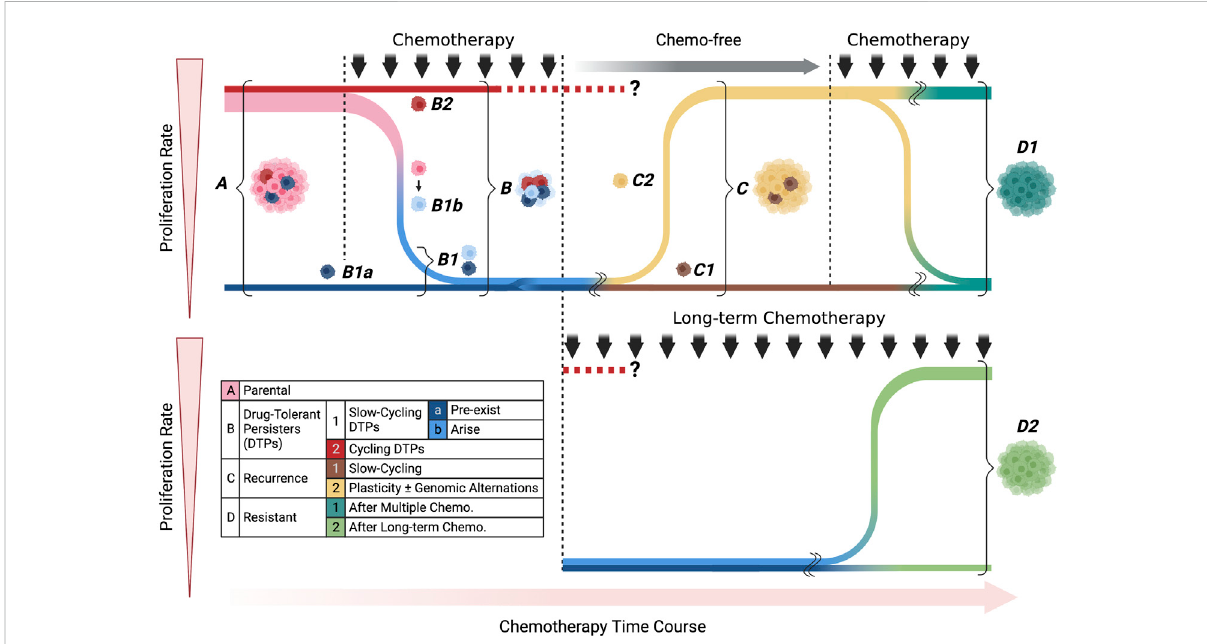
FIGURE 4 Classi fi cationoftreatment-survivedcellsbyproliferationrateandchemotherapytimecourse.Eachcolorcorrespondstothecellclassi fi cations shown in the included table. We divided the cell populations into four main categories: parental, drug-tolerant persisters (DTPs), recurrence, and resistant. In DTPs, we showed slow-cycling and cycling subcategories, pre-exist and arise populations in detail. Recurrence populations include slow-cycling and cycling populations, which could arise due to cell plasticity and/or genomic alternations. The resistant population was categorized according to the timeline of treatment: multiple or long-term